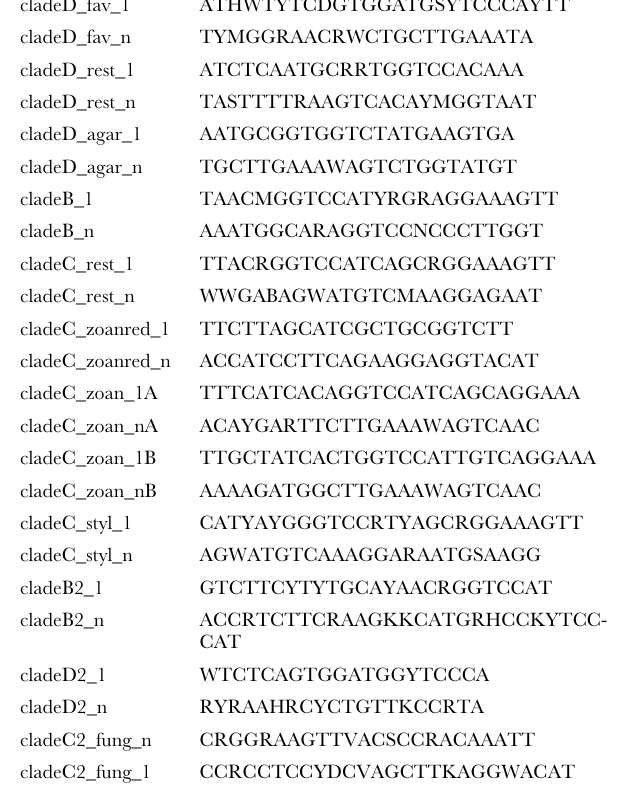
Table S1 List of GenBank accession numbers for all the sequences used in the phylogenetic analysis. The newly cloned sequences are shown in blue. File S1 FASTA-formatted alignment of the coding